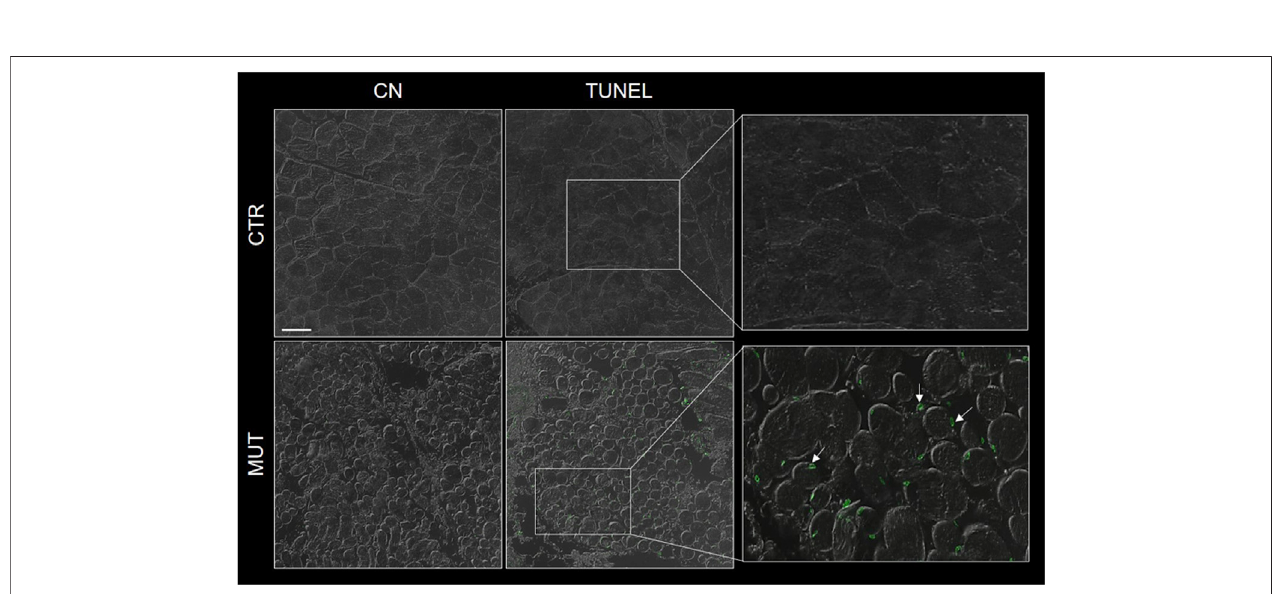
FIGURE 2 | Representative image of TUNEL assay of MUT and CTR muscles. DNA-strand breaks (green spots were more abundant in the MUT (white arrows in the panel with enlargement to the far right, bottom) an in the CTR muscle. CN, negative control for MUT and CTR muscles without TdT enzyme. Bar = 100 μ m.